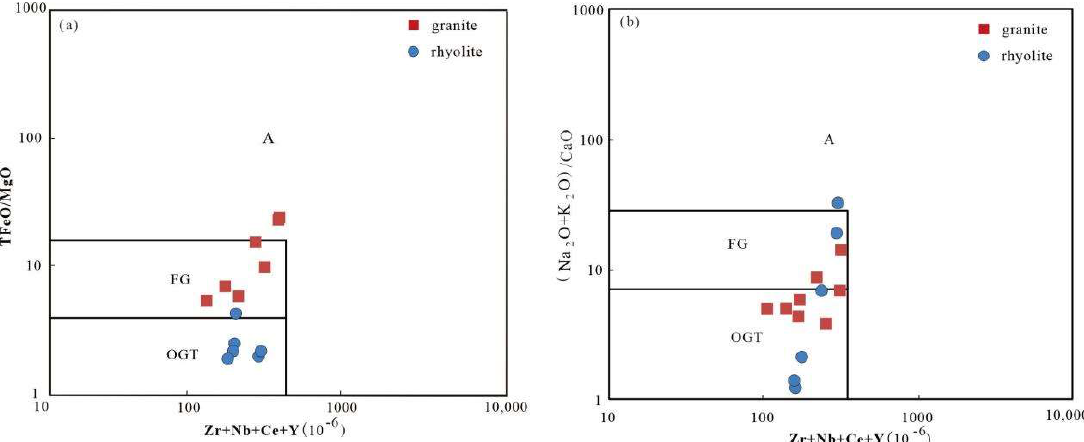
Figure 6. A discrimination diagram of the Early Cretaceous magmatic rock from the Badaguan area. ( a )TFeO/MgO−Zr + Nb + Ce + Y diagrams; ( b ) (Na 2 O+K 2 O)/CaO−Zr + Nb + Ce + Y diagrams ( a )TFeO/MgO–Zr + Nb + Ce + Y diagrams; ( b ) (Na 2 O + K 2 O)/CaO–Zr + Nb + Ce + Y